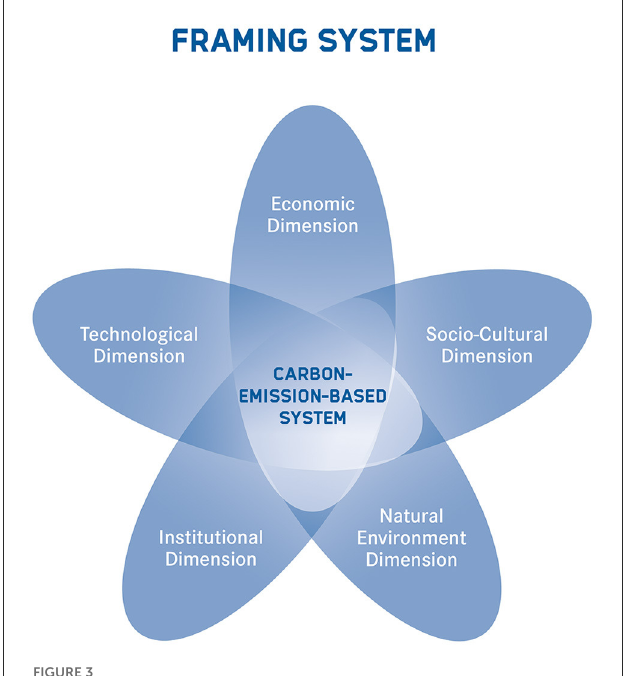
FIGURE3 The dimensions of the Net-Zero-2050 Framing